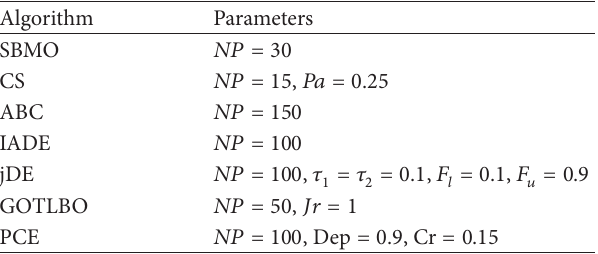
Table 2: Parameter configuration of seven